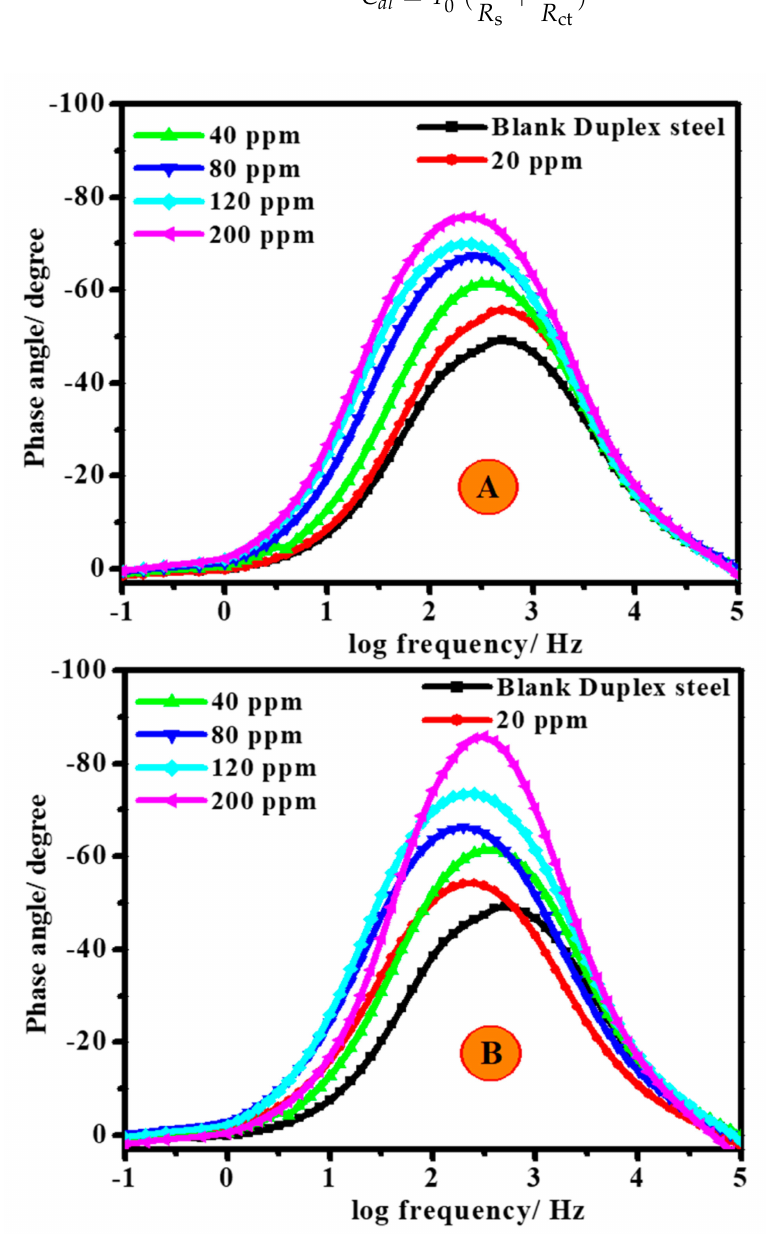
Figure 9. Bode phase profiles for duplex steel at 323 K in 2.0 M H 2 SO 4 with and without various concentrations of ( A ) CH and ( B ) CH/Zn@H 3